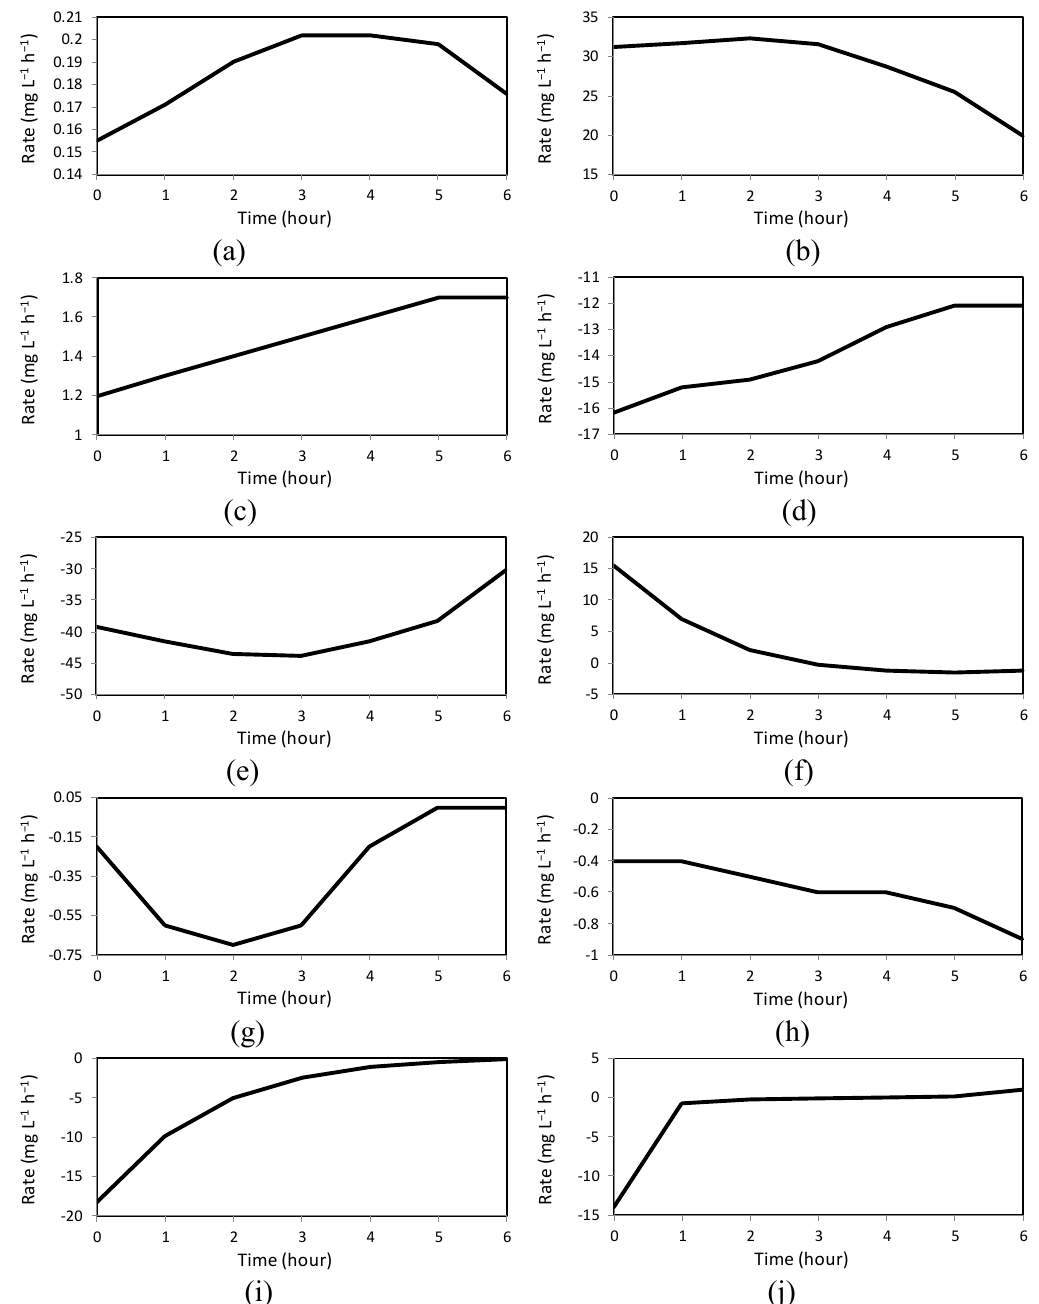
Figure 4. The RRs of different compounds at different flowing times. ( a ) Z HW , ( b ) Z HF , ( c ) Z E , ( d ) S ENM , ( e ) S BCS , ( f ) N H3 , ( g ) N O3 , ( h ) N BP , ( i ) N BS , and ( j ) S O2 . Before the 2nd hour, the r 2 (aerobic growth of Z HF in the biofilm) and r 4 (anoxic growth of Z HF in the biofilm) with positive signs were high because of high S BCS as shown in Figure 3. Therefore, the sum for the growth rate of Z HF (r 2 + r 4 ) was greater than r 8 (organism decay of Z HF in the biofilm) and the RRs began to increase before the 2nd hour. After the 2nd hour, the sum for the growth rate of Z HF (r 2 + r 4 ) was less than r 8 because the sum for the growth rate of Z HF became lower. Thus, the RRs revealed a decreasing trend after the 2nd